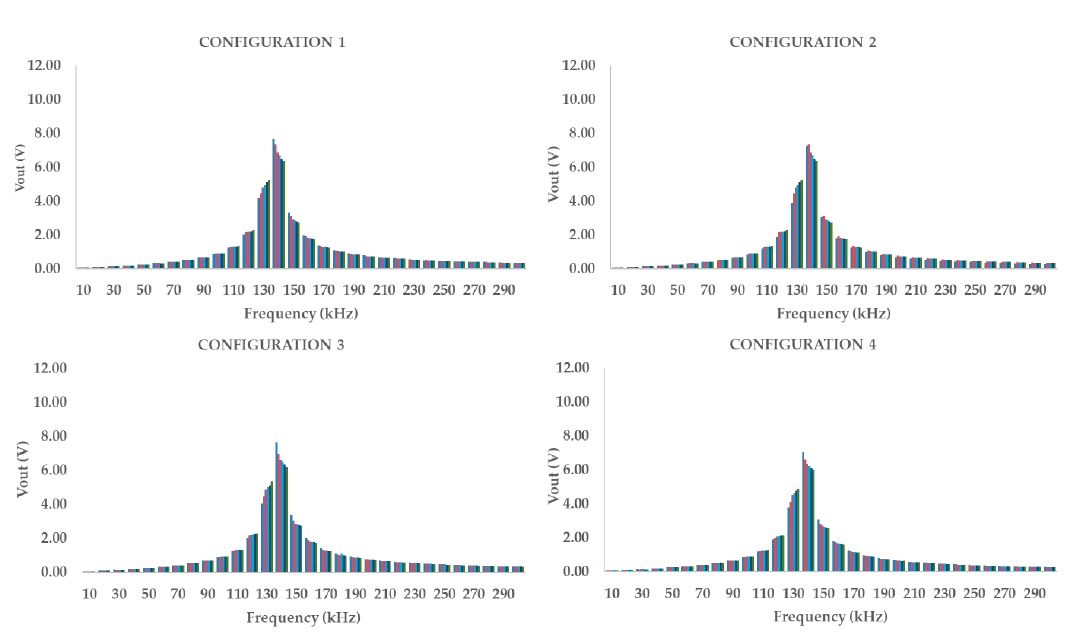
Figure 9. Representation of the frequency spectrum of P3 in the four different studied cases.